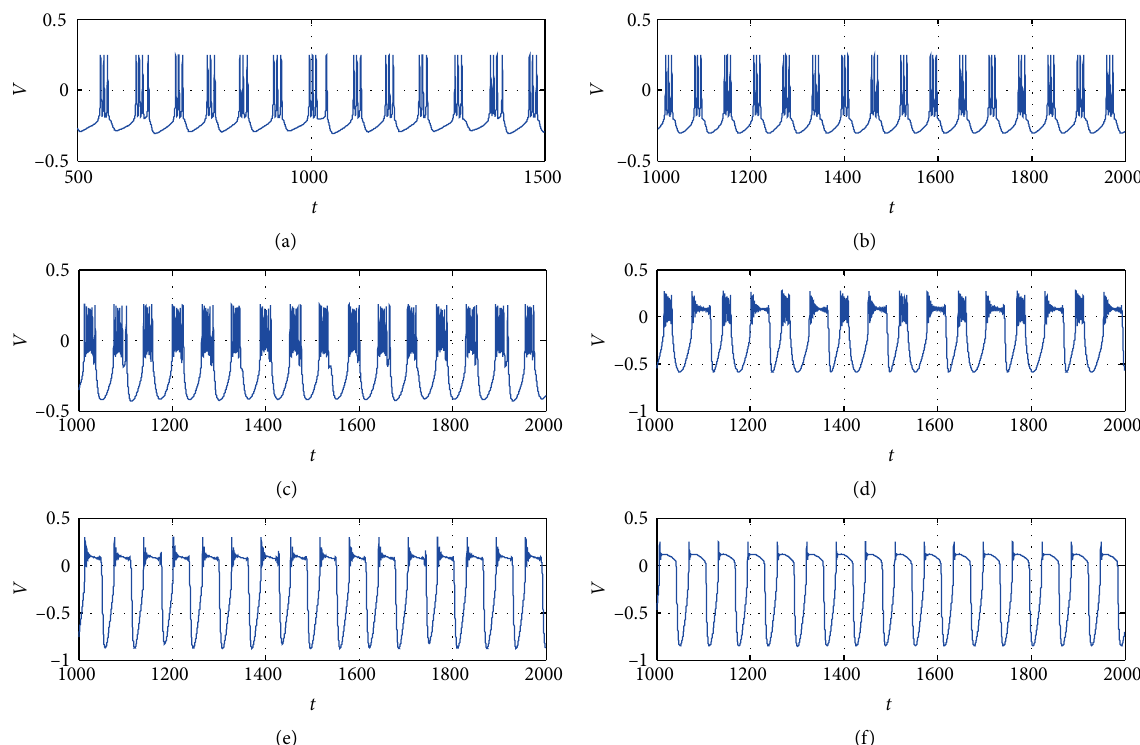
Figure 1: Sampled time series for membrane potential when the intensity of external forcing currents is chosen as different values with fixed angular frequency 𝜔 = 0.1 . (a) 𝐼 = 0.001 , (b) 𝐼 = 0.005 , (c) 𝐼 = 0.05 , (d) 𝐼 = 0.1 , (e) 𝐼 = 0.2 , and (f) 𝐼 = 0.5 . The effect of electromagnetic , 𝑘 , and 𝑘 radiation is considered by setting 𝑘 1 = 0.2 2 = 0.15 3 = 0.15